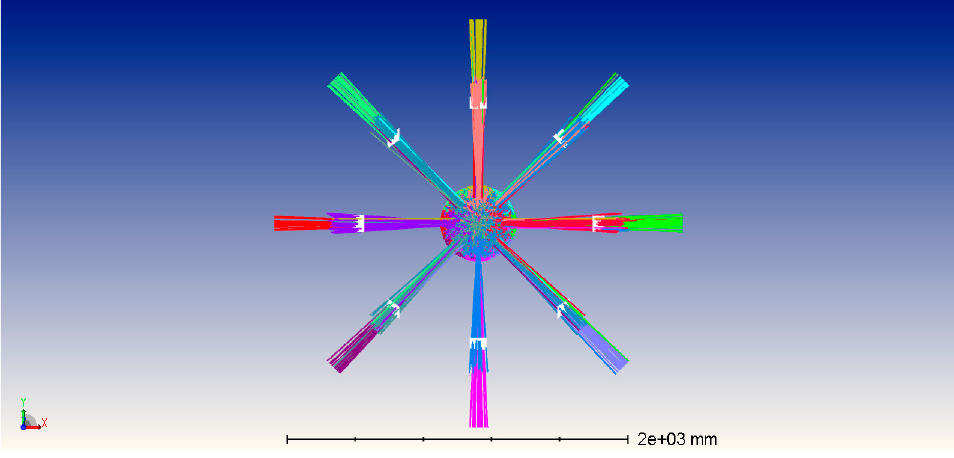
Figure 3. Transmitted beams by the hemispherical LED array. Adopting a beam-space channel model can convert the traditional physical space channel model to the angle domain by using only a partially negligible performance